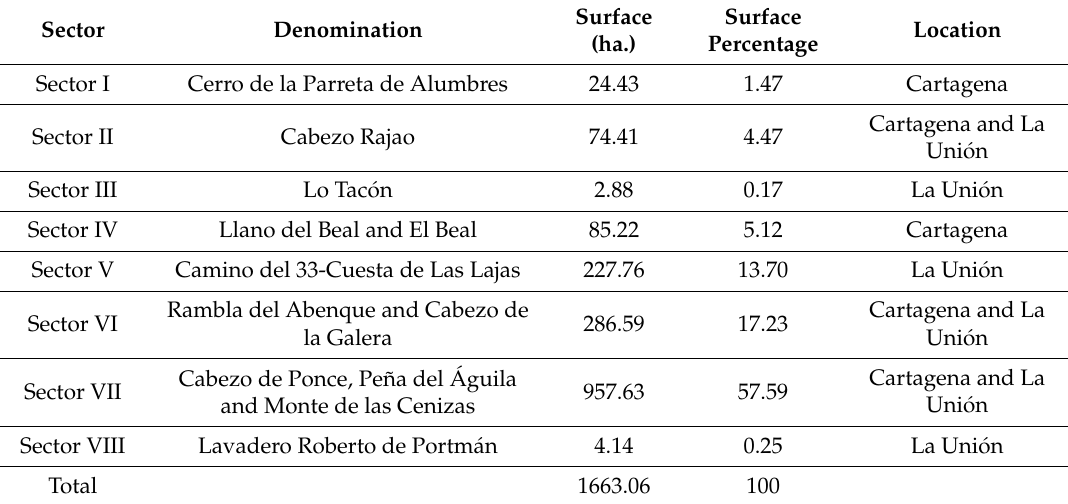
Table 2. Sectors of the protection zone.